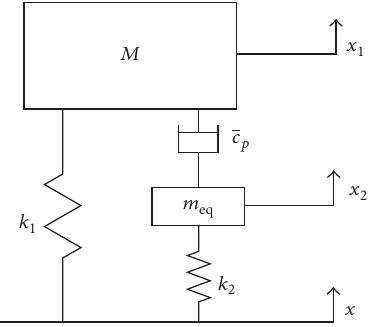
Figure 13: Equivalent system of the isolator with a displacement excitation